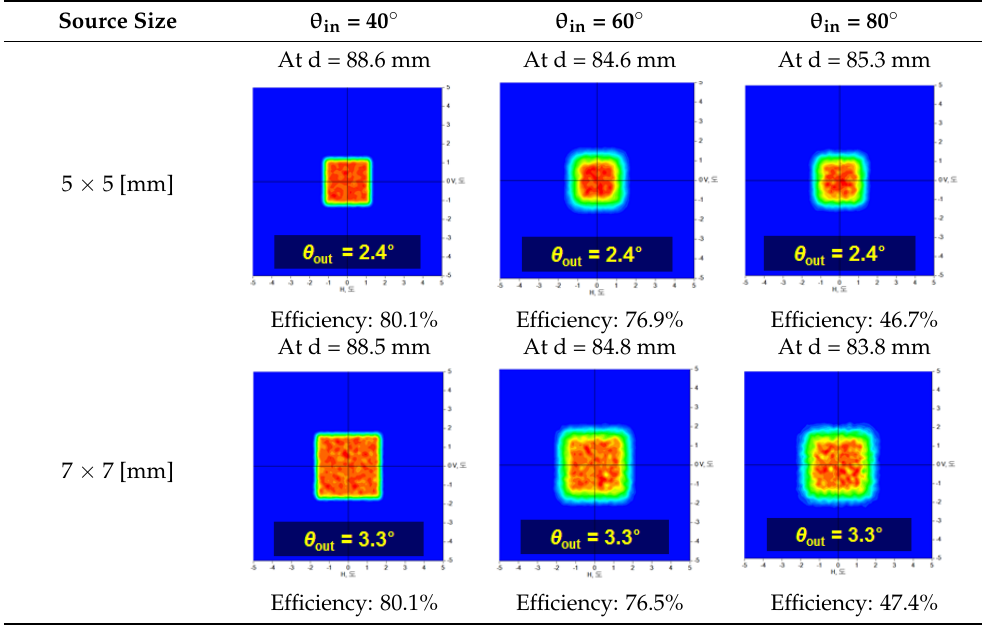
Table 2. Performance characteristics for large-area collimating optics.